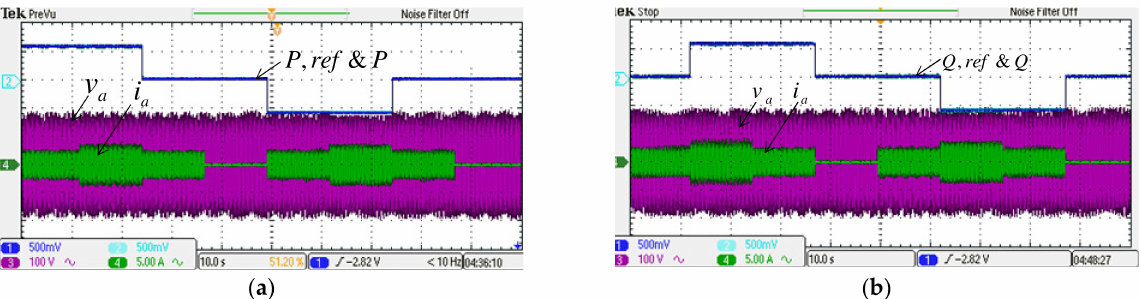
Figure 22. Implemented MG inverter waveforms in case 2: ( a ) active power and reference/a phase voltage and current; ( b ) reactive power and reference/phase-a voltage and